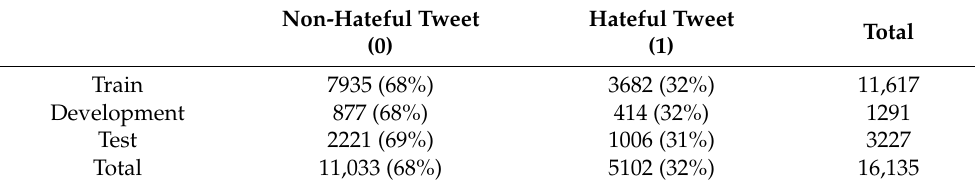
Table 5. ZeerakW dataset distribution of Non-hateful and Hateful